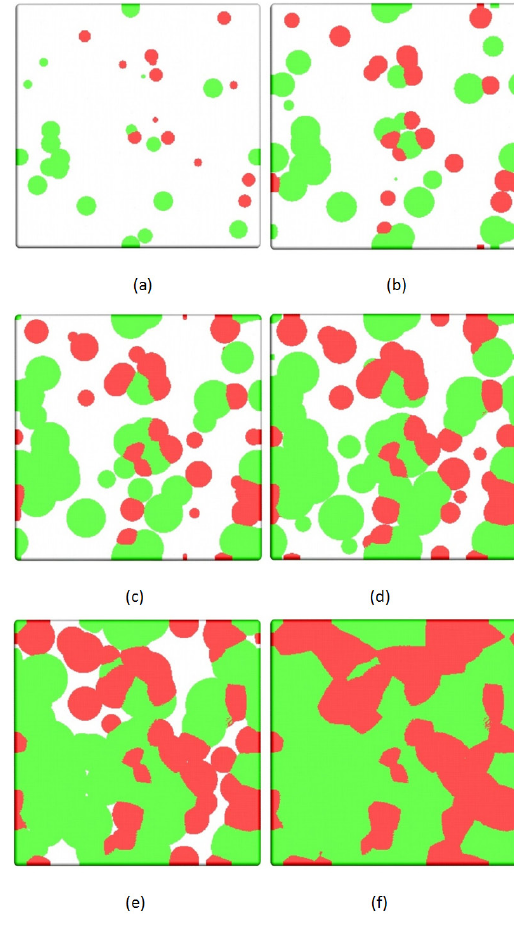
Figure 10. 2-d section of the 3-d presented above: volume fraction of γ -fiber (“green”) and other (“red”) orientations are, respectively,: a)0.03, 0.02 b)0.12, 0.08 c)0.25, 0.15, d)0.36, 0.24, e)0.48, 0.32 and f)0.58,